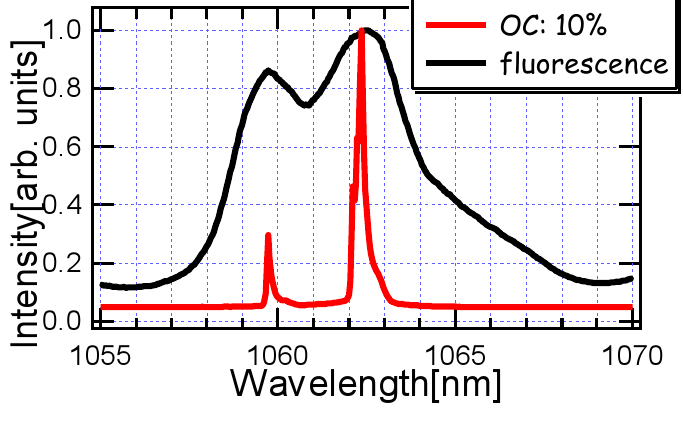
Figure 26. CW laser spectrum for 10% output coupler and the fluorescence